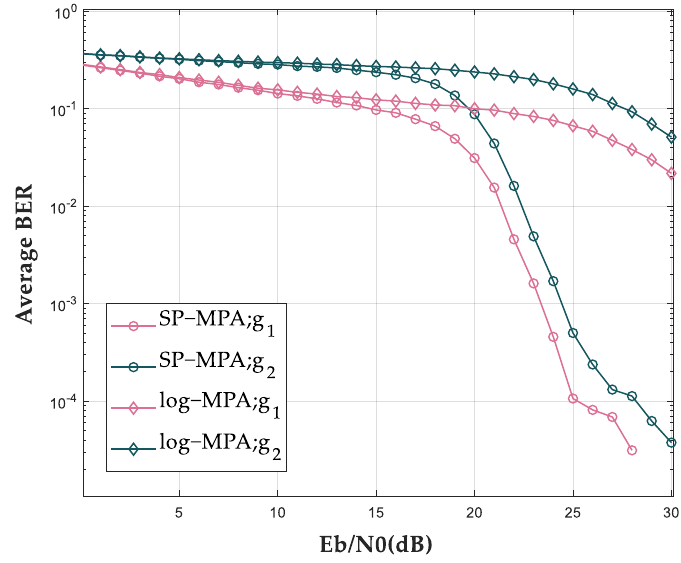
Figure 14. Average BER curves of log − MPA and SP − MPA.